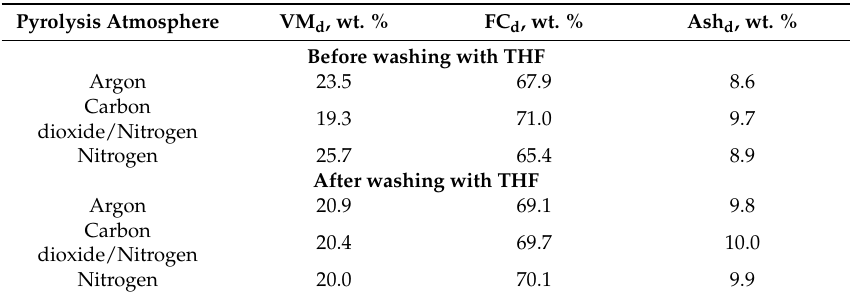
Table 3. Proximate analysis of the chars generated in different pyrolysis